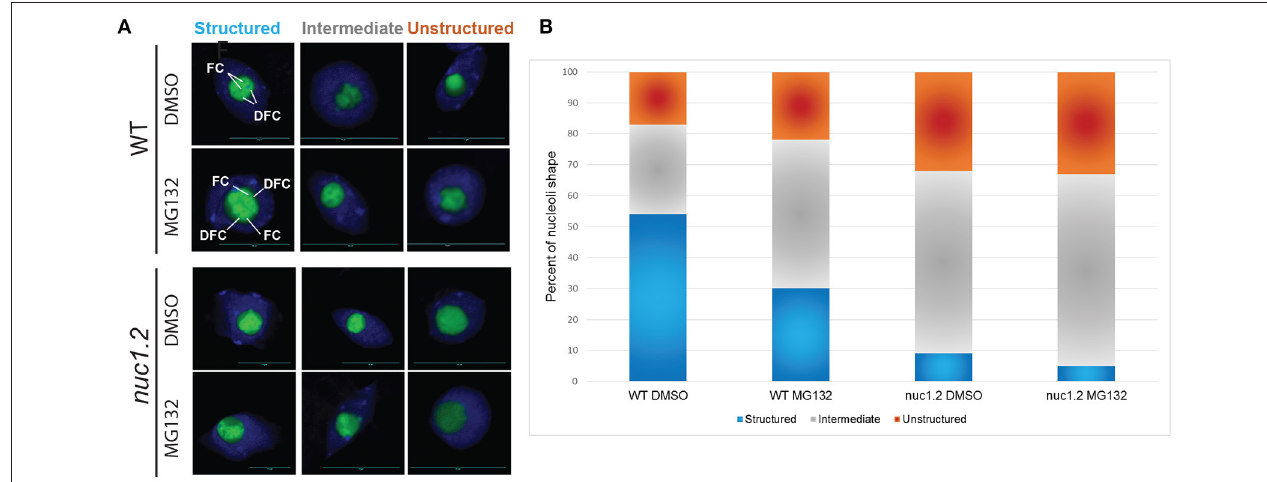
FIGURE 4 | MG132 proteasome inhibitor affects nucleolus structure. (A) Nucleoli from WT and nuc1.2 plants, expressing the Fib2:YFP constructs, treated or not with 50 µ M MG132. 100 nucleoli were analyzed in each sample. Green fluorescence of the Fib2:YFP, is used to visualize nucleolus organization with the FC (Fibrillar Centers), and the DFC (Dense Fibrillary Component) components in Structured, Intermediate and Unstructured forms. DAPI staining was used to visualize nucleoplasm and distinguish the nucleolus. (B) The bar graph depicts the percentage of structured (blue), intermediate (gray) and unstructured (orange) nucleoli in WT and nuc1.2 plants treated or not with 50 µ g MG132. Reactions without proteasome inhibitors (DMSO only) were used as control. 100 nuclei for each plants and conditions were analyzed. Scale bar = 10 µ m.